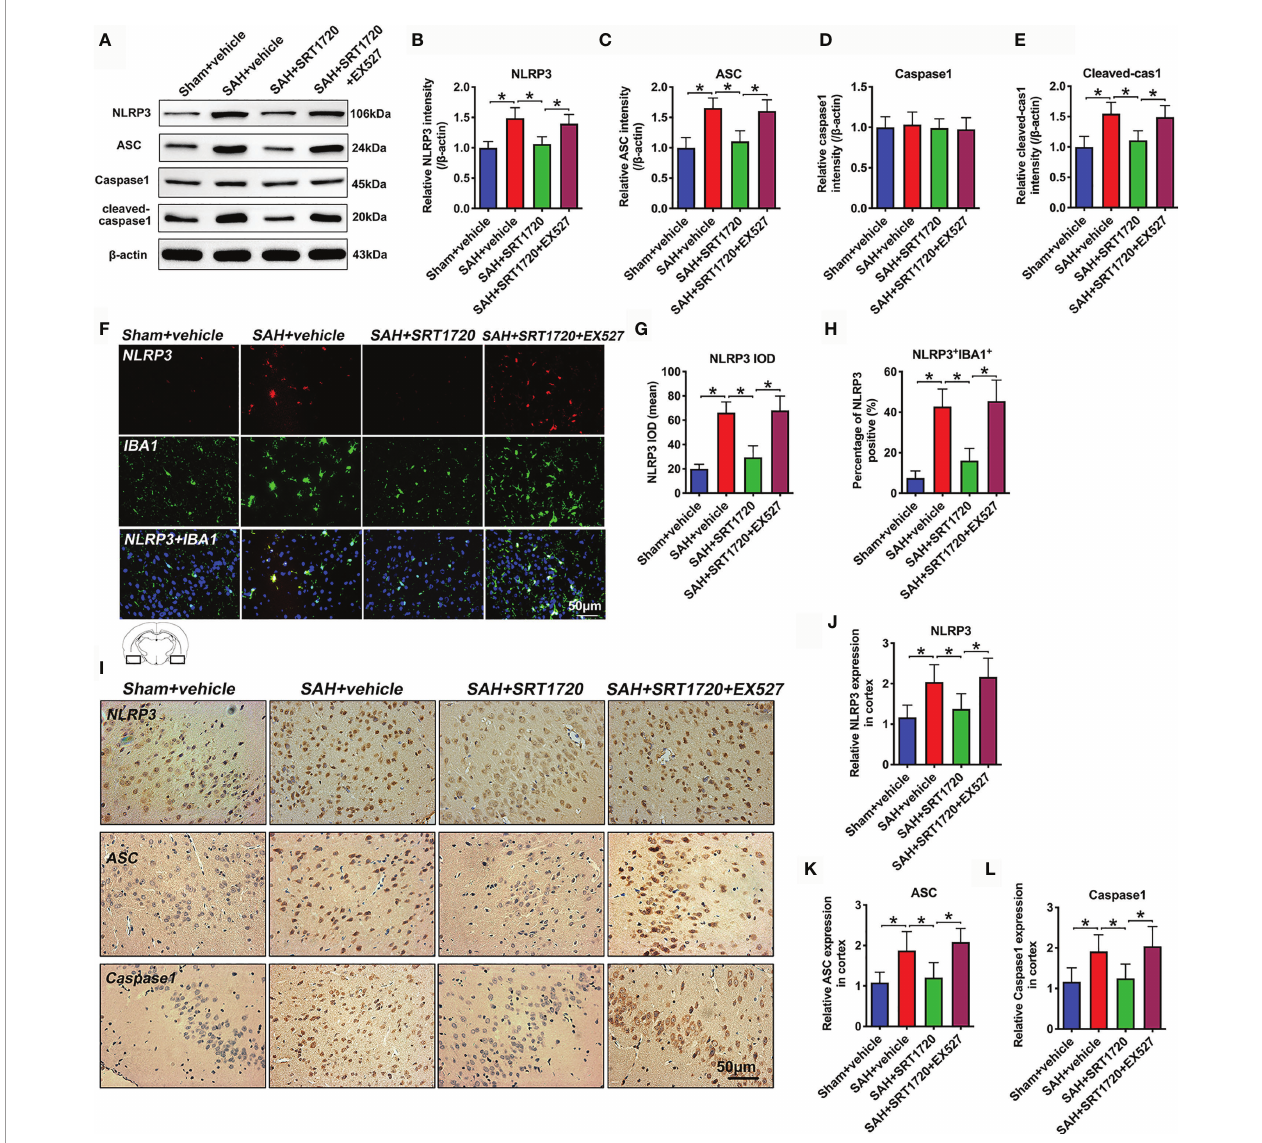
FIGURE 6 | Effects of SRT1720 treatment on NLRP3 in fl ammasome activation after SAH. Representative western blots (A) and quanti fi cation of expressions of NLRP3 (B) , ASC (C) , caspase1 (D) , and cleaved caspase1 (E) in all groups. Representative photomicrographs (F) and quanti fi cation of NLRP3 immuno fl uorescence staining (G, H) . Representative photomicrographs (I) and quanti fi cation of NLRP3 (J) , ASC (K) , and cleaved caspase-1 (L) immunohistochemistry staining. For histopathology studies, the basal temporal lobe adjacent to the clotted blood was evaluated. Bars represent the mean ± SD. Bars represent the mean ± SD. * P <